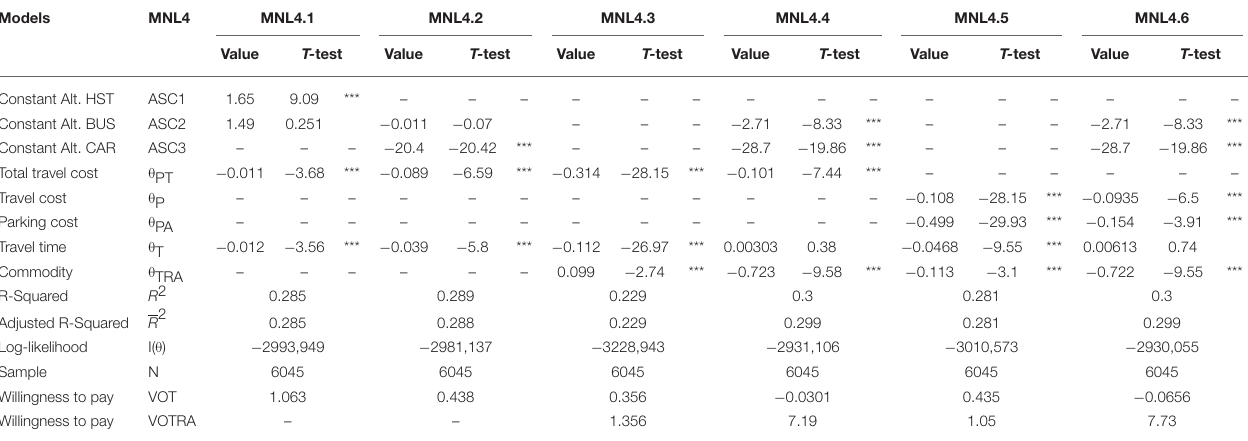
TABLE 4 | Results of MNL models estimated with three alternatives and with scaled